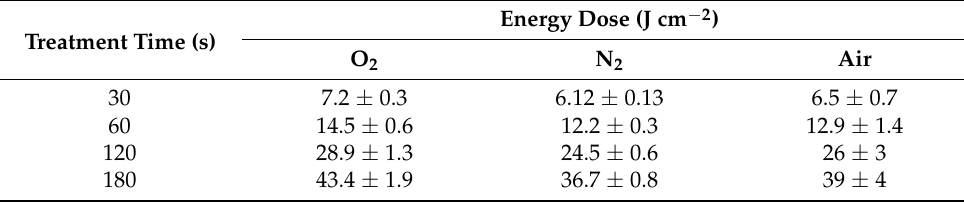
Table 1. Energy doses (J cm − 2 ) of plasma in DBD ignited in different feed gases (O 2 , N 2 , and synthetic Air with 0.5 slm of flow rate) and different treatment times. The experimental conditions are 13 kV, 6 kHz, and 25% DC with a period of 100 ms on 2 mL of DMEM.